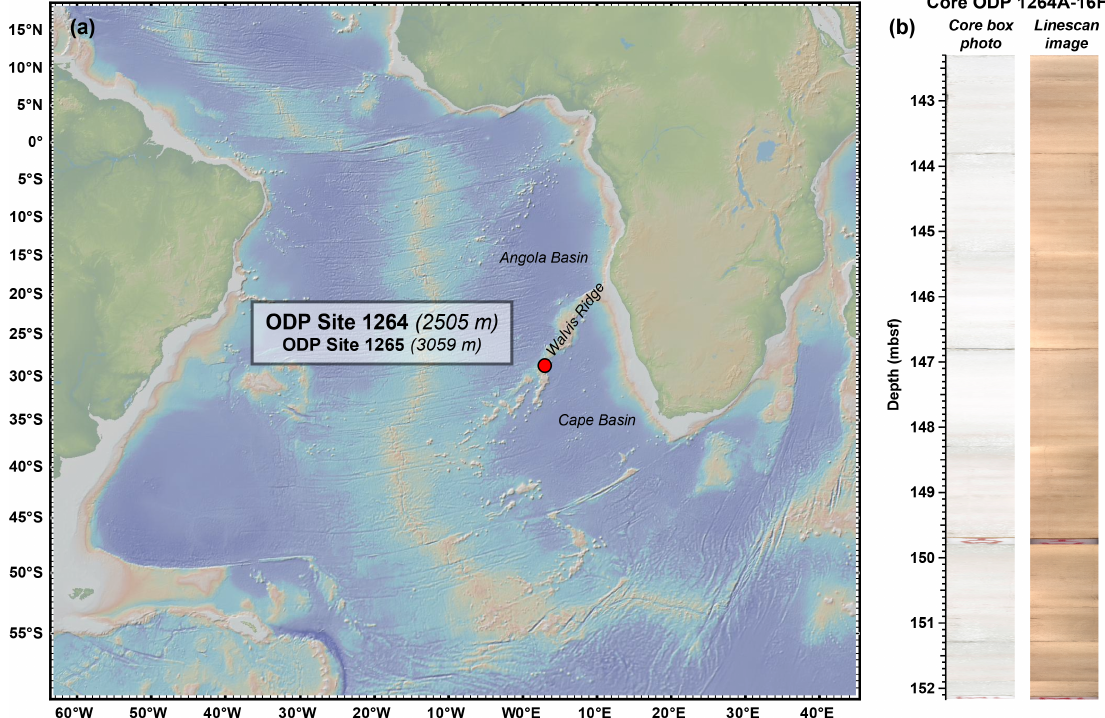
Figure 1. (a) Site overview showing location of Sites 1264 and 1265 on the Angola Basin side of Walvis Ridge, as well as (b) the differences between core box photos and line scan images compiled with CODD. Figure made with GeoMapApp (http://www.geomapapp.org, last access: 9 September 2021)/CC BY/CC BY (Ryan et al.,